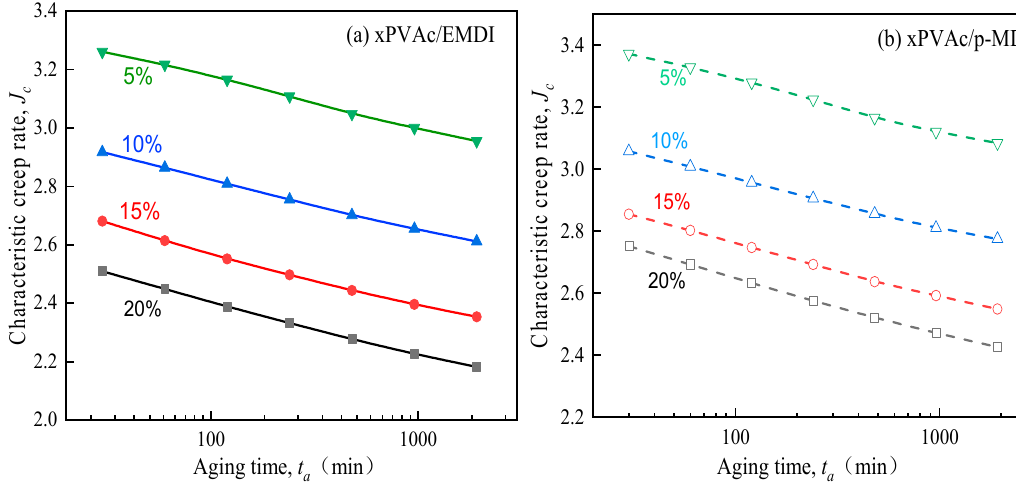
Figure 4. Effect of isocyanate crosslinkers on the characteristic creep rate for cured EPI films.